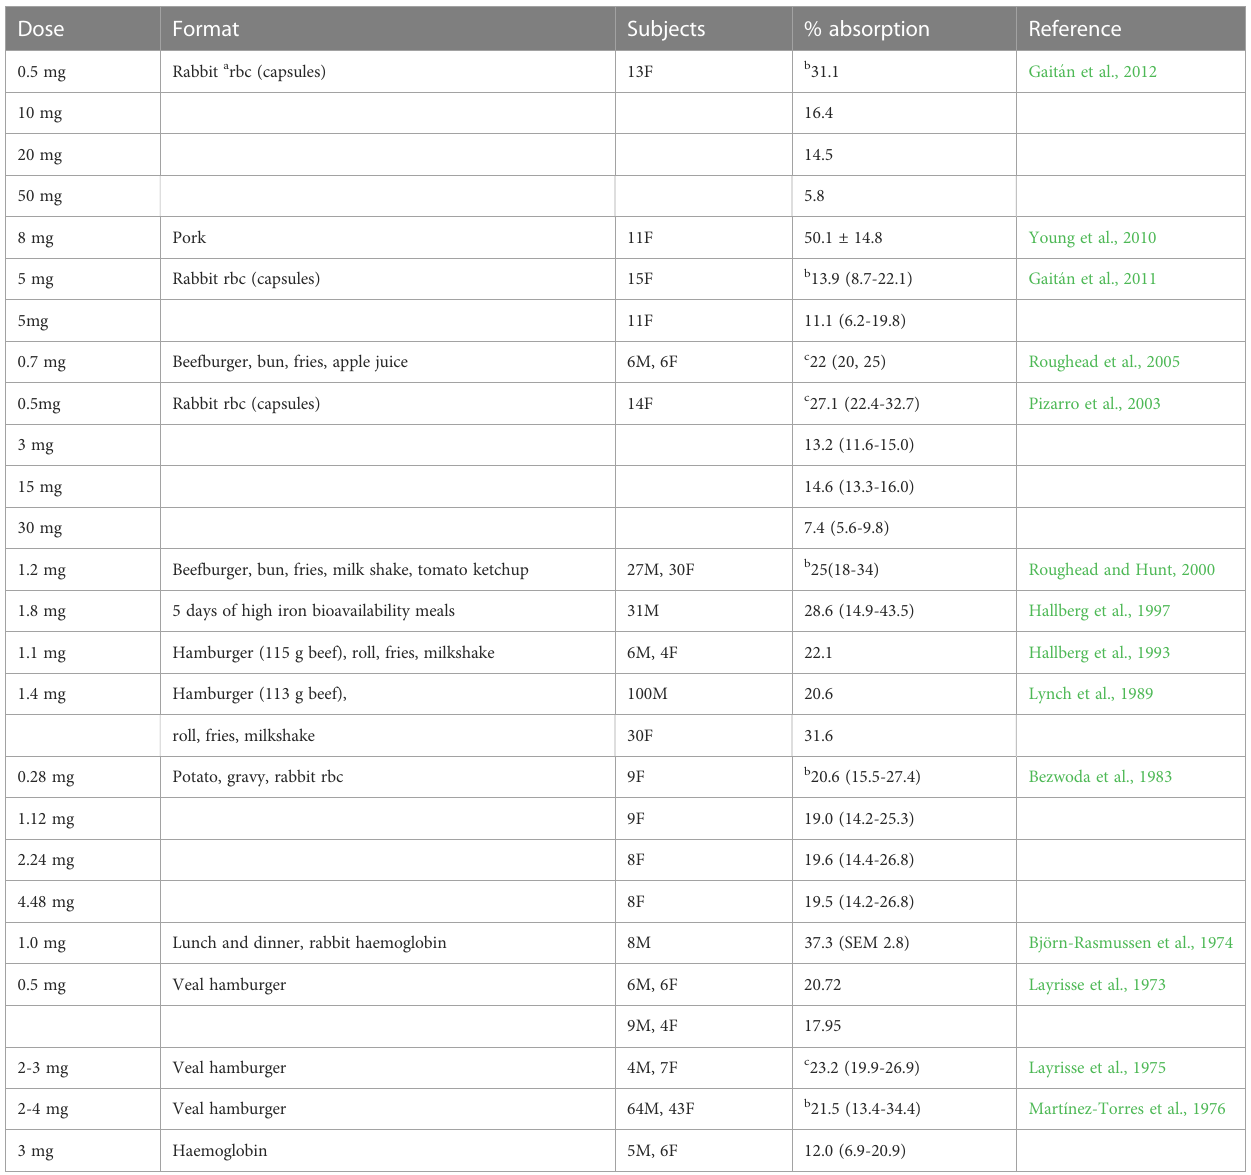
TABLE 3 Absorption of isotopically-labelled haem